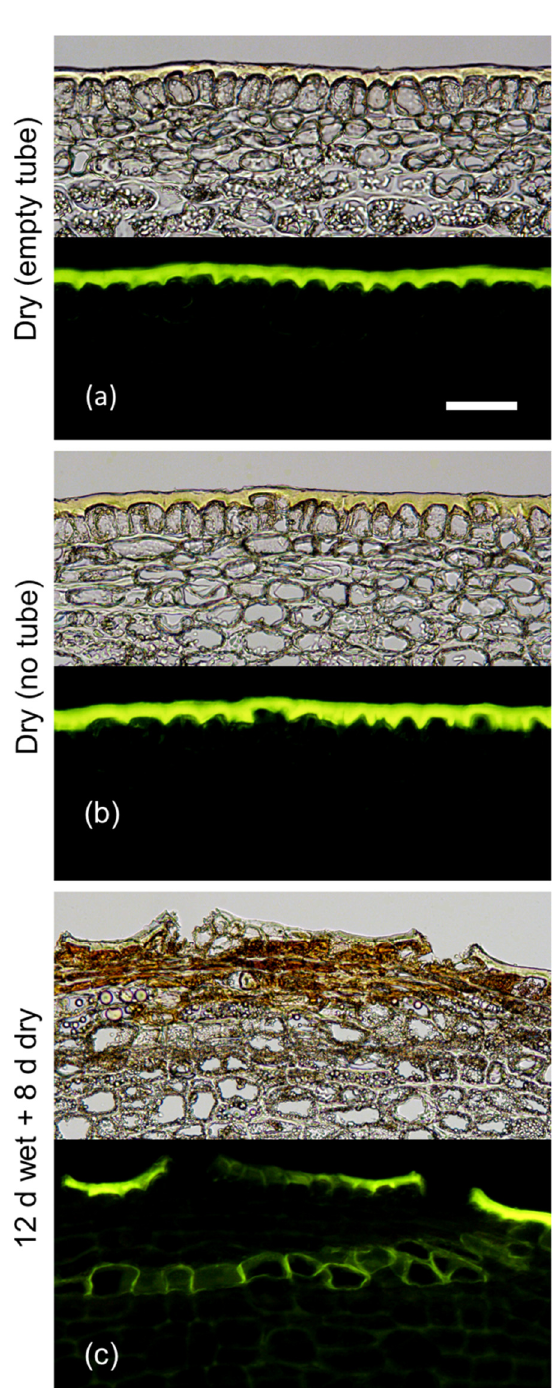
Figure 1. Effects of mounting tubes on the fruit surface without and with added moisture for 12 d, on the formation of periderm 8 d after removal of the tubes. ( a ) control that had a tube without water mounted for 12 d. ( b ) control without tube. ( c ) moisture treatment that had a tube containing water mounted for 12 d. The experiment comprised two phases: Phase I consisted of mounting the tube without or with water and Phase II marks the period after termination of moisture treatment. Micrographs taken under transmitted white light (upper) or incident fluorescent light (lower) (filter module U-MWB) following staining with Fluorol Yellow 088. The scale bar in ( a ) is 50 µm long and representative of all images in the composite ( n = 3).